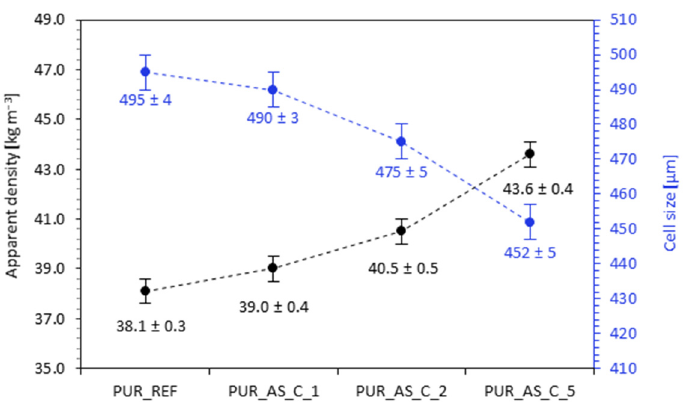
Figure 8. Apparent density and average cell diameter of PUR composites reinforced with ca- sein/apricot filler.